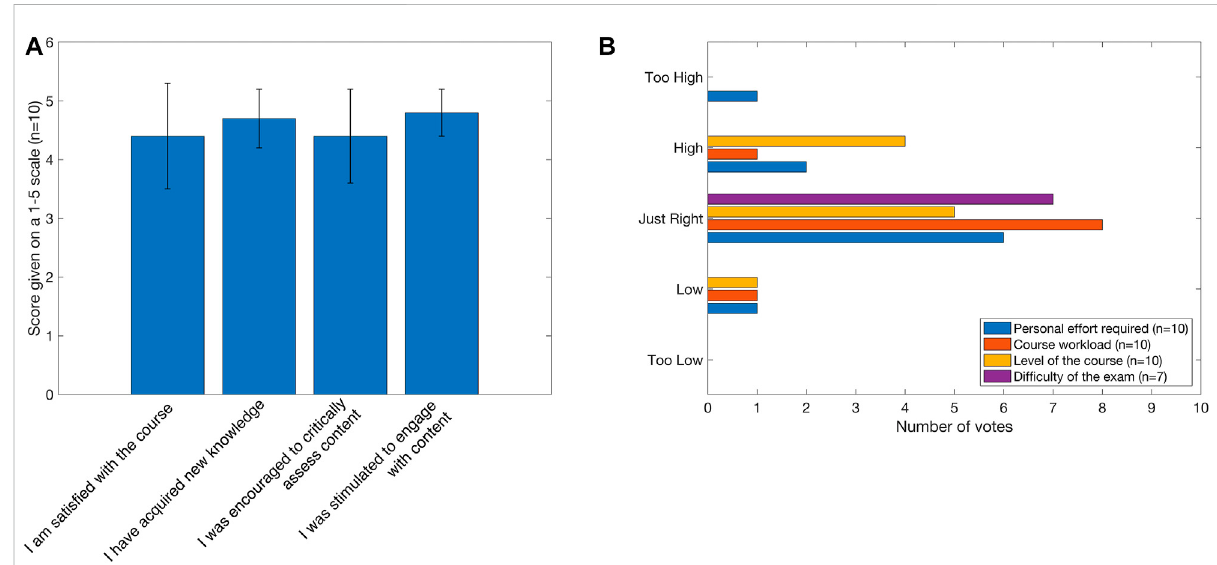
FIGURE 3 Summary statistics of course survey. (A) Students evaluated the course satisfaction level by rating each statement from one (low) to fi ve (high) scores. Error bars represent standard deviation. (B) Students provided opinions on the course and exam by providing a rank (from “ too low/easy ” to “ too high/hard ” )for aset ofstatements. As some studentsdid not sit theexam, n isless for thisstatement than others. The full survey and statements can be found in the GitLab